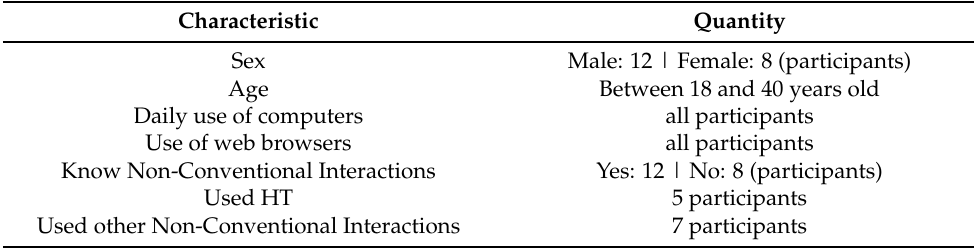
Table 1. Characteristics of participants in the first stage of tests.